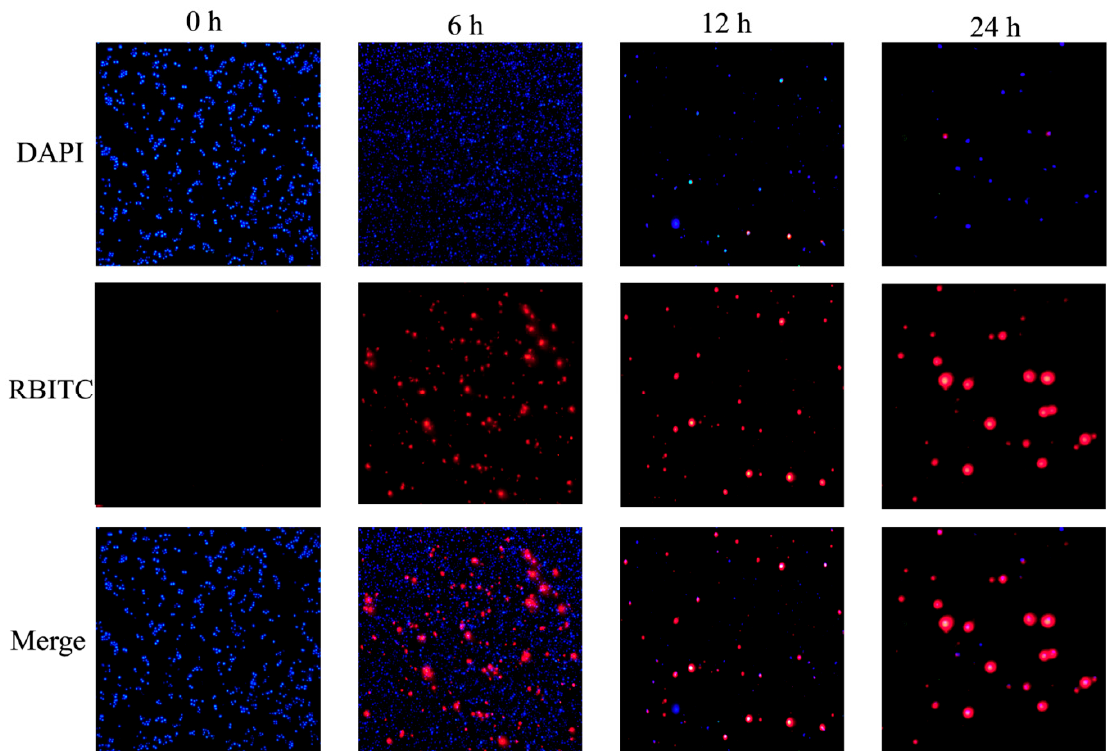
Figure 6. Cellular uptake of PCAC-NPs by RAW 264.7 macrophages. RAW 264.7 macrophages were treated with RBITC- labeled NPs (red) for 0, 6, 12 and 24 h, and the fixed cells were stained with DAPI to observe the nucleus (blue).